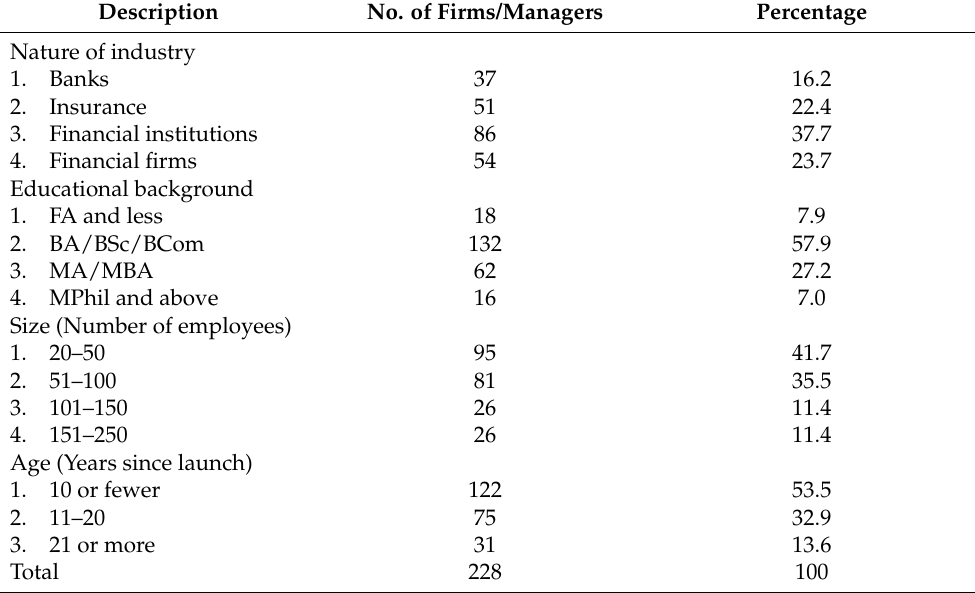
Table 1. Profile of the